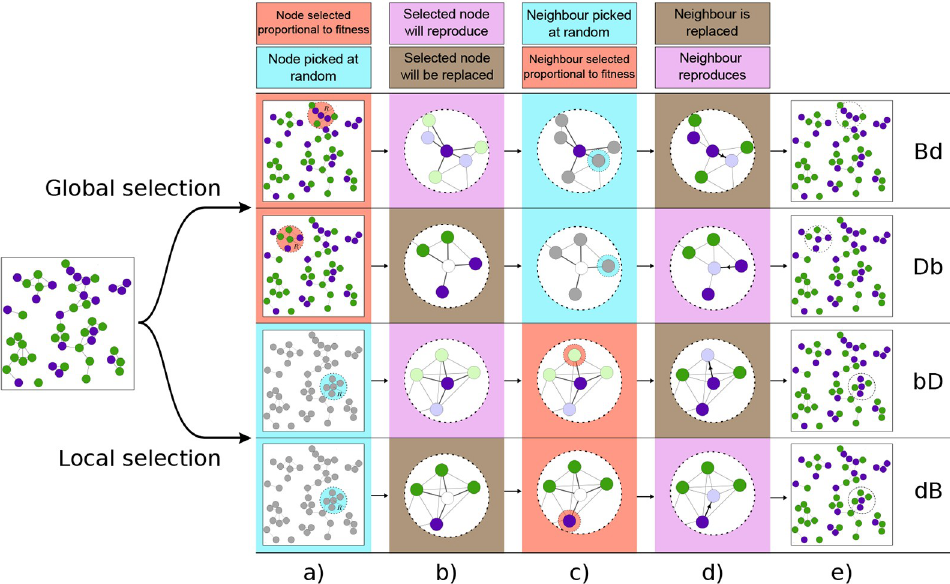
Fig 1. Illustration of the update rules. Each row represents one of the different evolutionary update mechanisms. The columns indicate the different steps of each evolutionary event. In column a) an individual is chosen from the whole population; it can be ‘selected’ through competition by fitness (red shading), or ‘picked’ at random, irrespective of its species (blue shading). This node is destined to either reproduce (pink shading), or to be replaced (brown shading), as shown in column b). Column c) indicates that one neighbour of this node is either selected (red), or picked (blue). This second node is destined to reproduce (pink), or to be replaced (brown), shown in column d). Column e) shows the result of the evolutionary event; the node chosen to reproduce places an offspring in place of the node chosen to die. Each row is composed of one box of each colour; the sequence of the colours distinguishes the different processes. From top to bottom, the rows correspond to: (i) global birth-death process ( Bd ): an individual is selected from the whole population to reproduce, and one of its neighbours is picked to be replaced by the first individual’s offspring; (ii) global death-birth process ( Db ): an individual is selected to die from the whole population, and one of its neighbours is picked to place an offspring in its place; (iii) local birth-death process ( bD ): an individual is picked from the whole population to reproduce, and one of its neighbours is selected to die; (iv) local death-birth process ( dB ): an individual is picked from the whole population to die, and one of its neighbours is selected to reproduce.